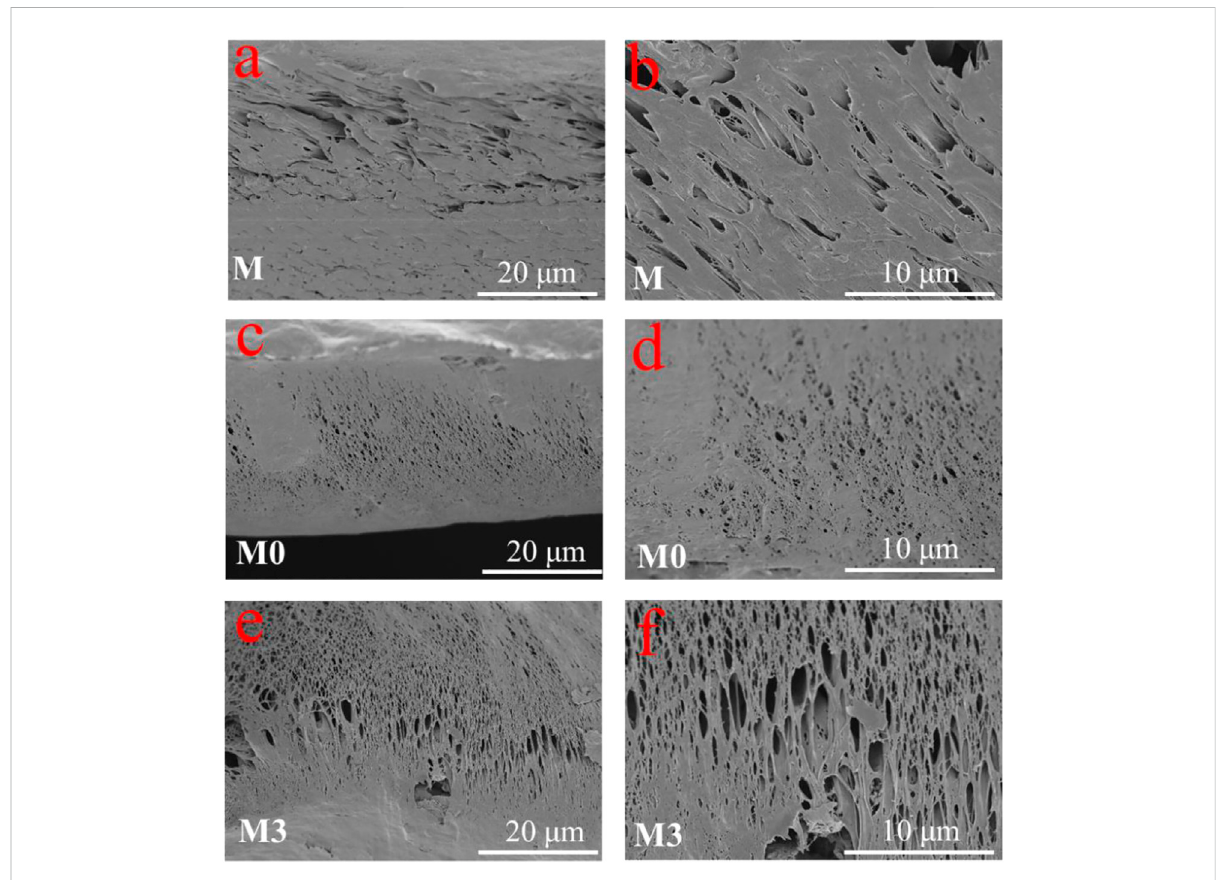
FIGURE 5 Cross-sectional SEM images of the (A) M membrane, (C) M0 membrane, (E) M3 membrane; and high magni fi cation of (B) M membrane, (D) M0 membrane, (F) M3 membrane.